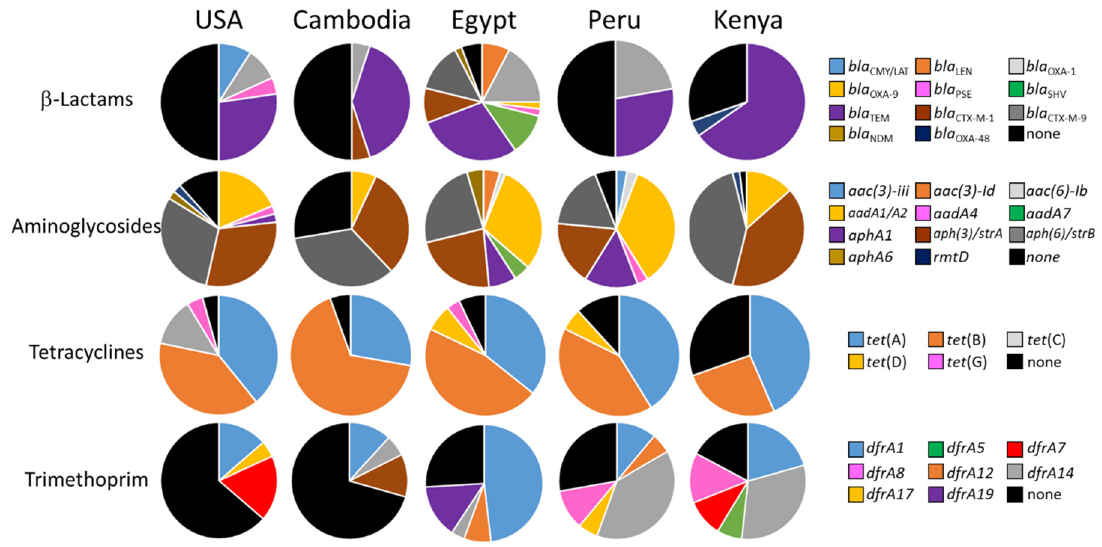
Figure 4. Pie charts showing carriage rates of ARDs conferring resistance to β -lactams, aminoglycosides, tetracyclines, and trimethoprim among E. coli , Shigella spp., and Salmonella . Black pie slices indicate the percentage of isolates that were negative for all tested ARDs in that category. Note that many strains carried multiple β -lactamase and aminoglycoside ARDs.